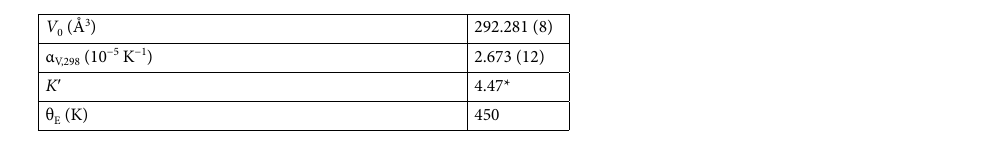
Table 2. Thermoelastic parameters for olivine Mg 1.84 Fe 0.16 SiO 4 . Thermoelastic parameters of the olivine studied in this work obtained using a Kroll-type equation of state available on EoSFit7 software 18 . The first pressure derivative K ′ was taken from 17 . *This value is from 17 .